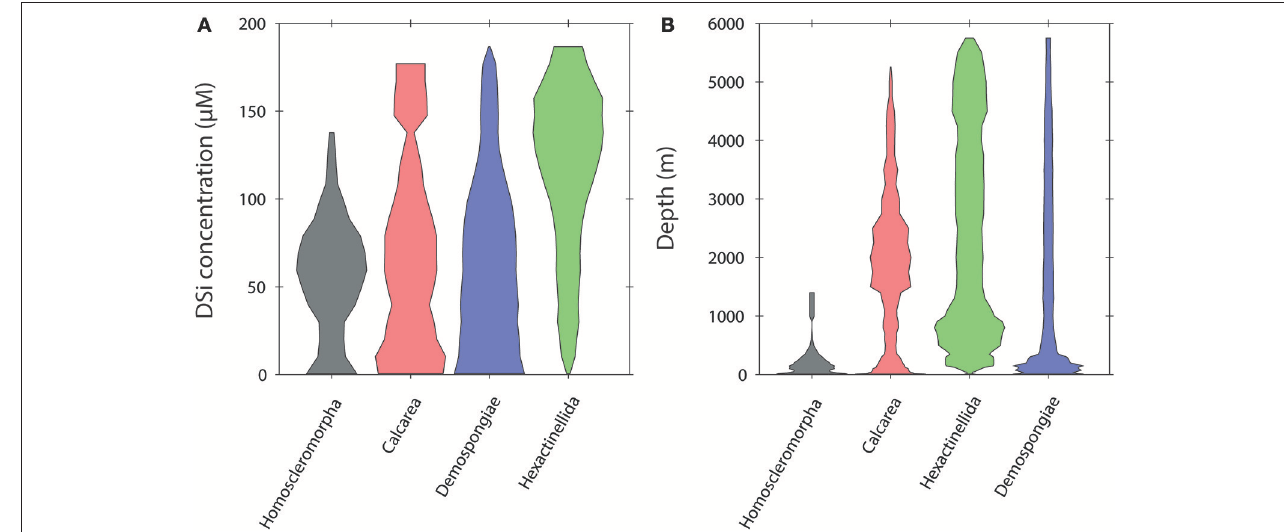
FIGURE 3 | Violin plots showing the distribution of the sponge classes in a dSi gradient (A) and a depth gradient (B)